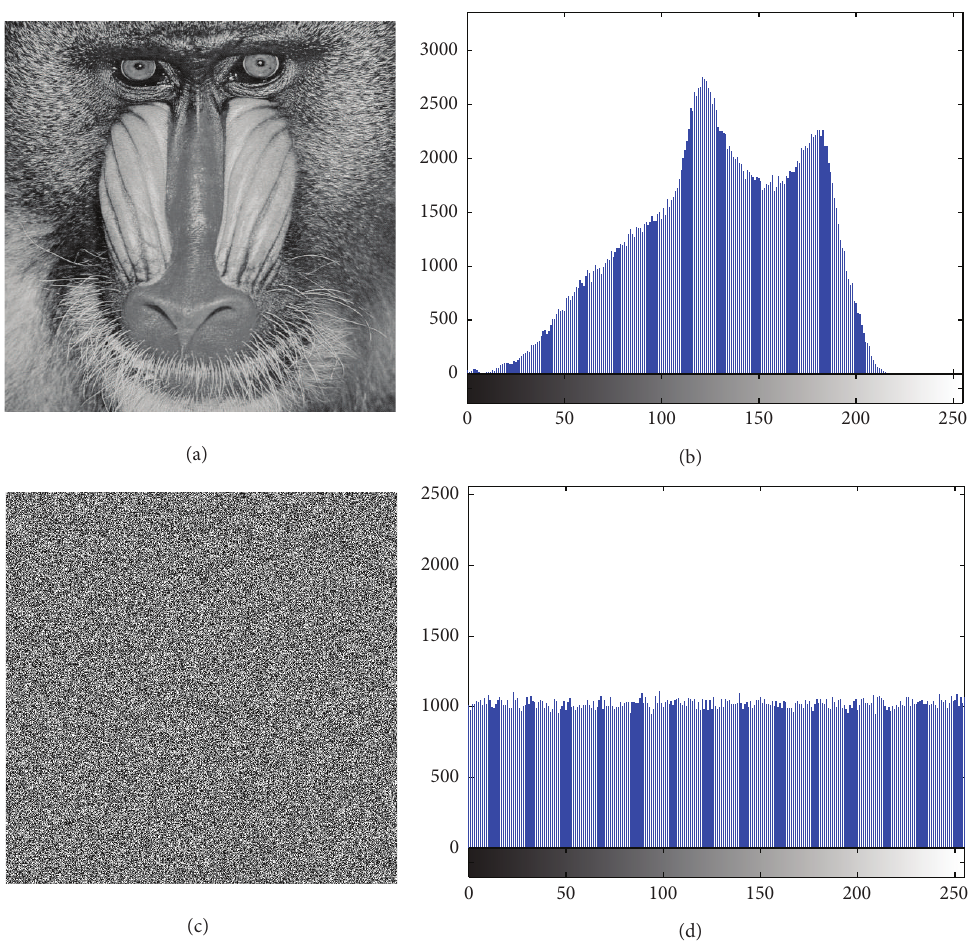
Figure 12: (a) Baboon image and (b) its histograms and (c) encrypted image and (d) its histogram.